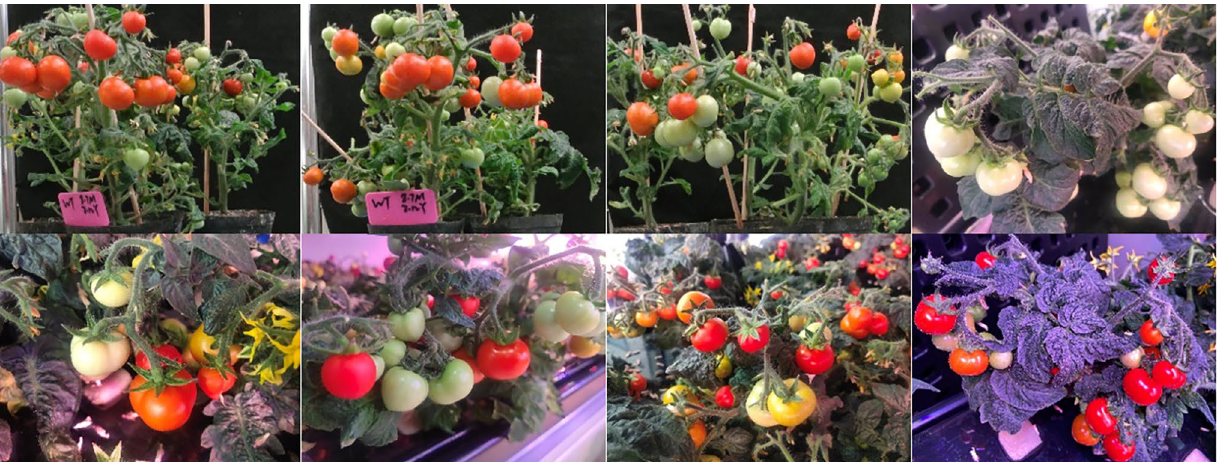
Figure 2. Samples of collected original image